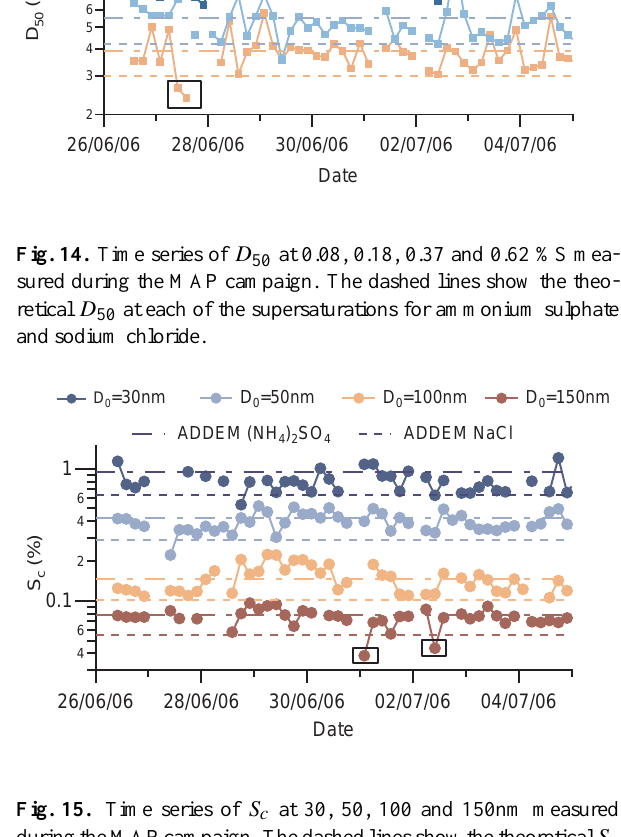
Fig. 15. Time series of S c at 30, 50, 100 and 150nm measured during the MAP campaign. The dashed lines show the theoretical S c at each of the supersaturations for ammonium sulphate and sodium